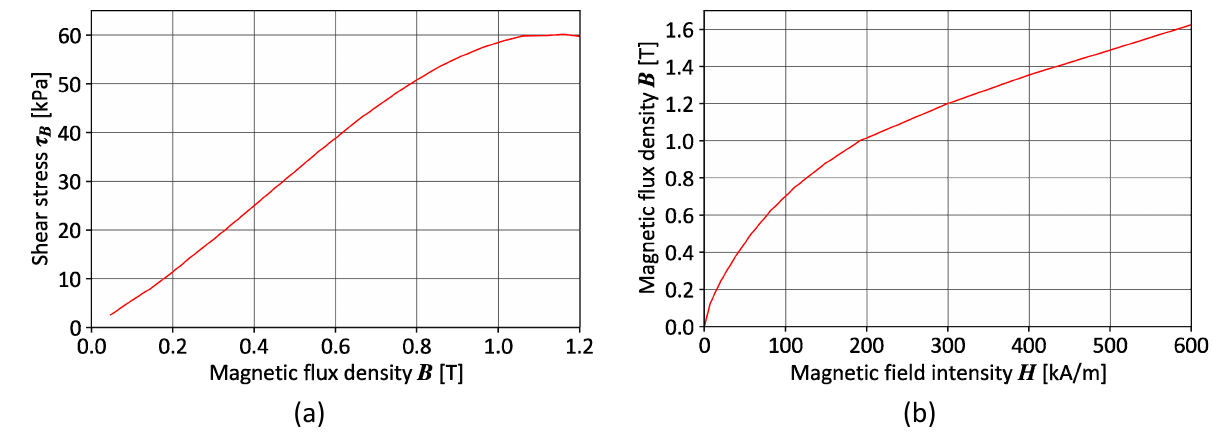
Figure 7. Information about MRF and stress analysis within the article: ( a ) shear stress τ B versus magnetic flux density B curve [47]; ( b ) magnetic flux density B versus magnetic field intensity H for MRF-140CG [45].